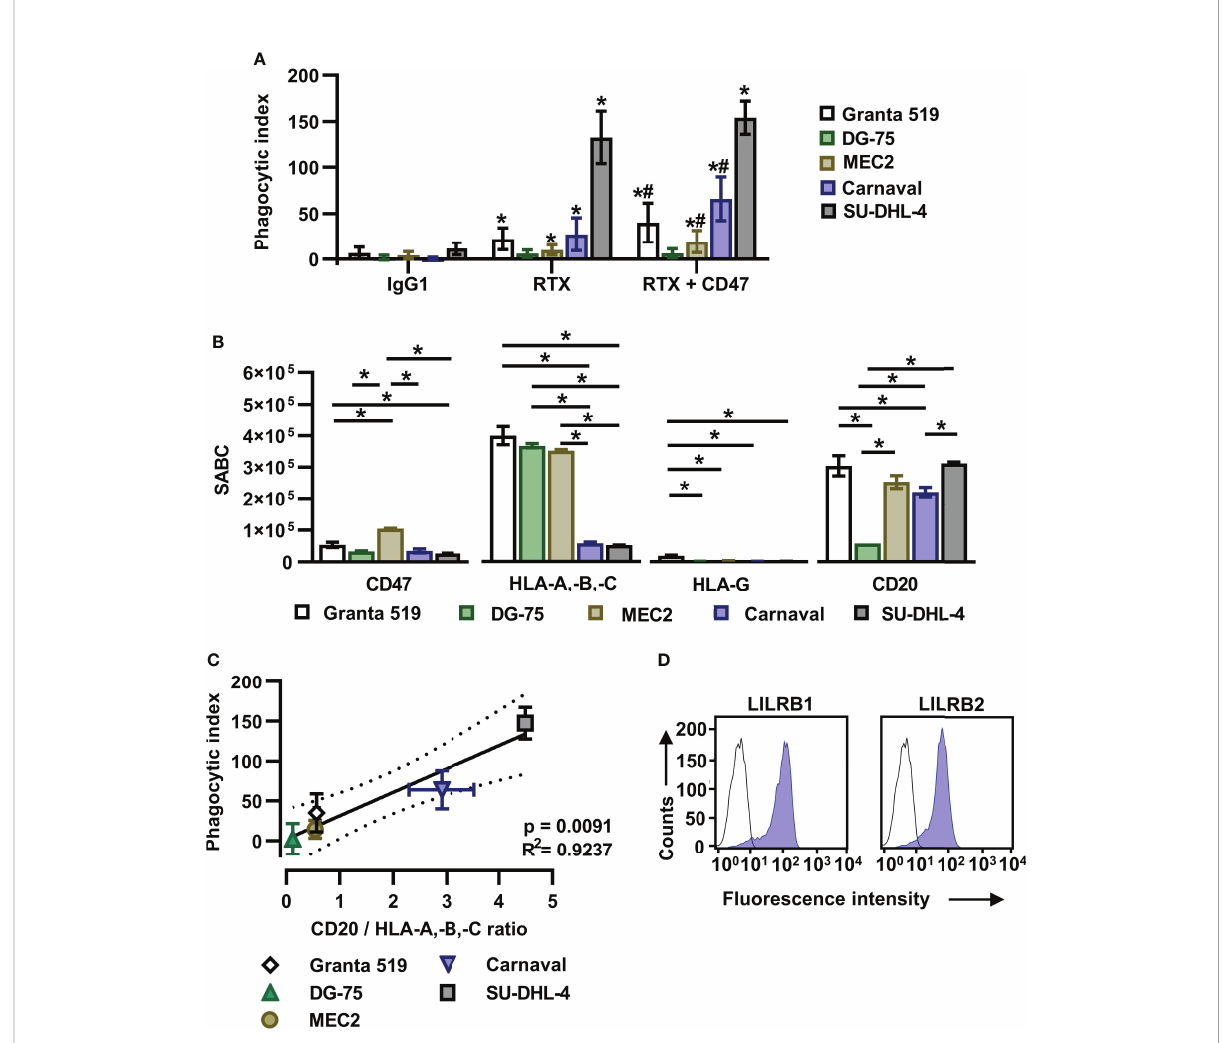
FIGURE 1 The ratio of CD20 to HLA-A,-B,-C antigen expression determines the ef fi cacy of the combination of rituximab and a CD47 blocking antibody in initiating ADCP. (A) Human M0 macrophages were incubated with CFSE-labeled Granta 519 ( n = 8), DG-75 ( n = 6), MEC2 ( n = 10), Carnaval ( n = 11) or SU-DHL-4 ( n = 4) lymphoma cells (E:T cell ratio: 1:2) in the presence of either rituximab (RTX) or a combination of RTX plus CD47-IgG s (CD47) for 2 h. ADCP was analyzed by fl uorescence microscopy and the phagocytic index was calculated. Trastuzumab (IgG1) was used as control. Antibodies were applied at 10 µg/ml. Bars represent mean values ± SD. Statistically signi fi cant differences (P ≤ 0.05) in ADCP compared to treatment with IgG1 (*) or RTX (#) are indicated (Two-way ANOVA with Tukey ’ s multiple comparisons test). (B) Lymphoma cells were stained with antibodies speci fi c for CD20, CD47, HLA-A,-B,-C or HLA-G and speci fi c antibody binding capacities (SABC) were determined by calibrated fl ow cytometry. Bars indicate mean values ± SEM ( n = 3). Statistically signi fi cant differences between individual lymphoma cell lines are indicated (*P ≤ 0.05; one-way ANOVA with Tukey ’ s post hoc test). (C) For each lymphoma cell line the ratio of CD20 to HLA-A,-B,-C expression was determined and plotted against the calculated mean phagocytic index values for treatment with RTX plus CD47-IgG s . The solid line represents the best- fi t curve, dotted lines indicate the 95% con fi dence interval. Error bars indicate SD. (D) M0 macrophages were stained with murine antibodies against LILRB1 or LILRB2 (blue shaded peaks) or an isotype control antibody (black outlined peaks). Secondary FITC-conjugated goat anti-mouse immunoglobulins (DAKO) were used for detection. Cell surface expression was analyzed by fl ow cytometry. One representative experiment is shown ( n =